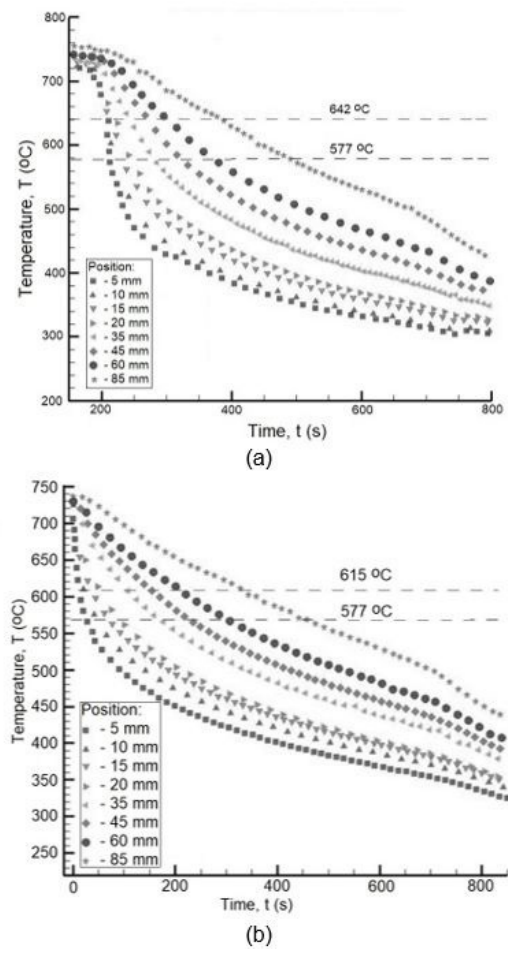
Figure 5. Phase diagram of Al-Si system as computed with the Thermo-Calc Software 33 with Aluminum Database v4.0.